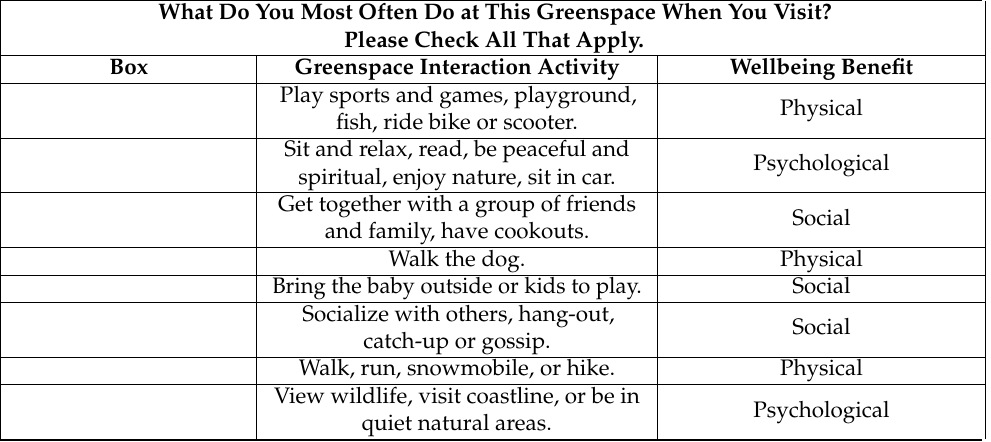
Table 2. Greenspace questionnaire interaction type with coded human wellbeing benefits in italics. What Do You Most Often Do at This Greenspace When You Visit? Please Check All That Apply. Box Greenspace Interaction Activity Wellbeing Benefit Play sports and games,